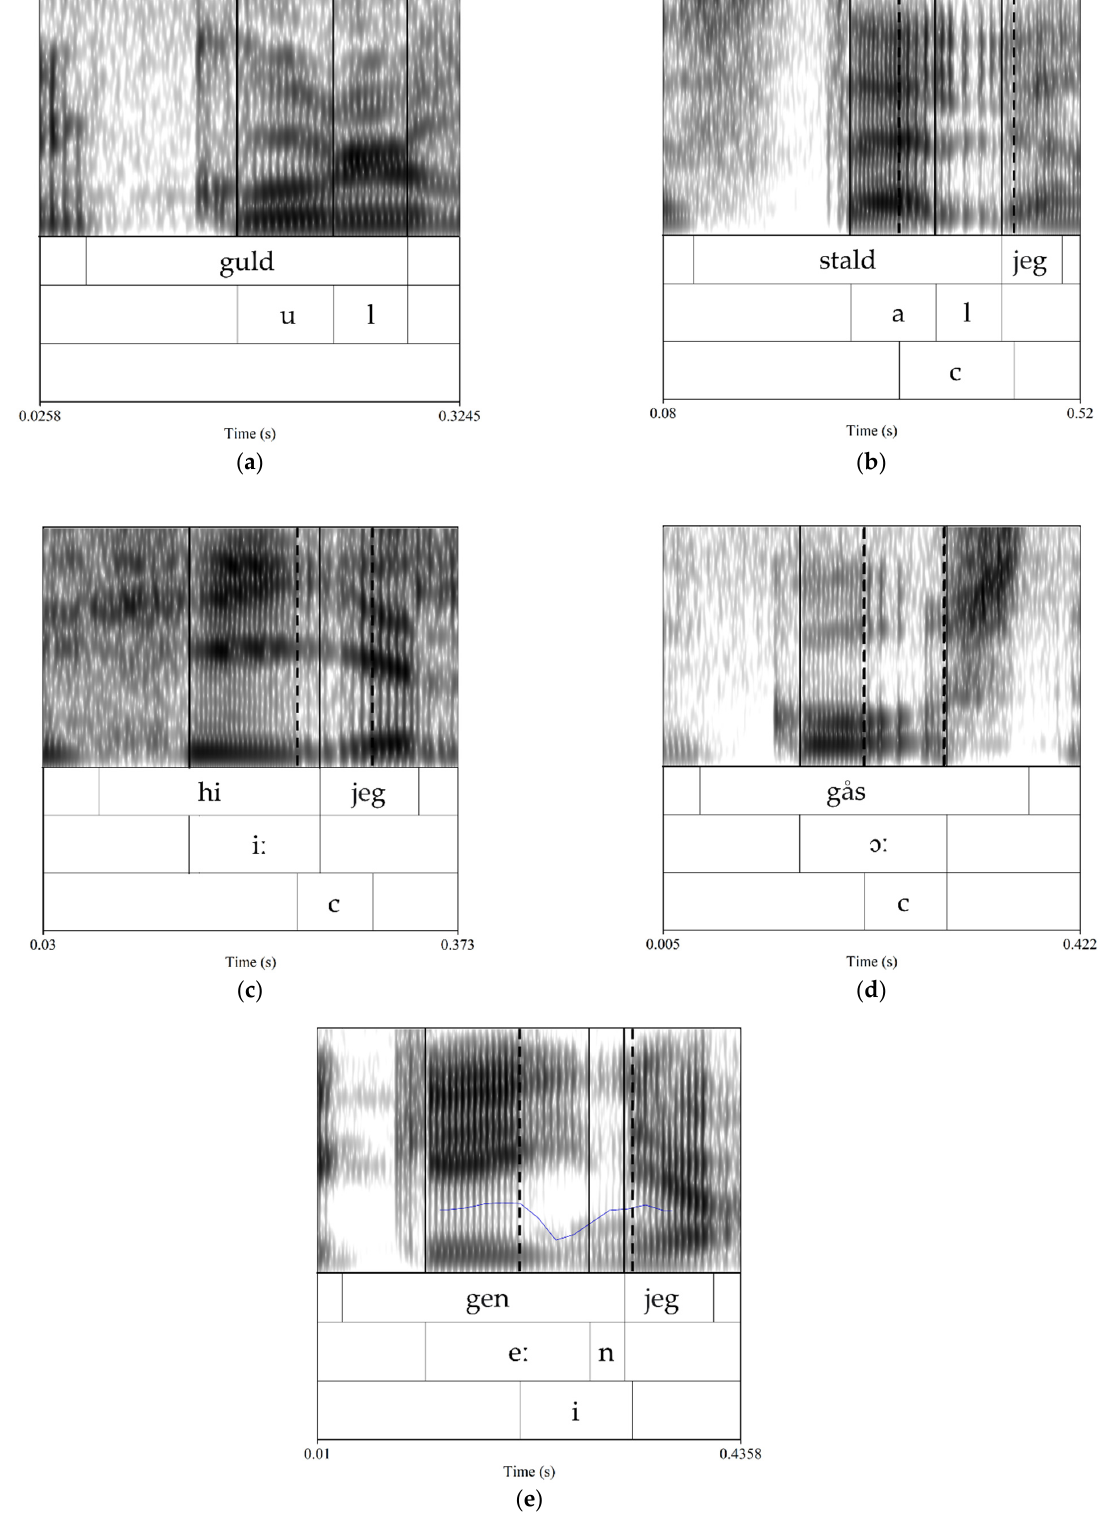
Figure 5. Segmental (solid lines) and voice quality (dashed lines) segmentations for CVS, CVS ˀ , CV ːˀ , CV ːˀ O, and CV ːˀ S words. For CVS ˀ , CV ːˀ , and CV ːˀ S words the following word is also segmented.